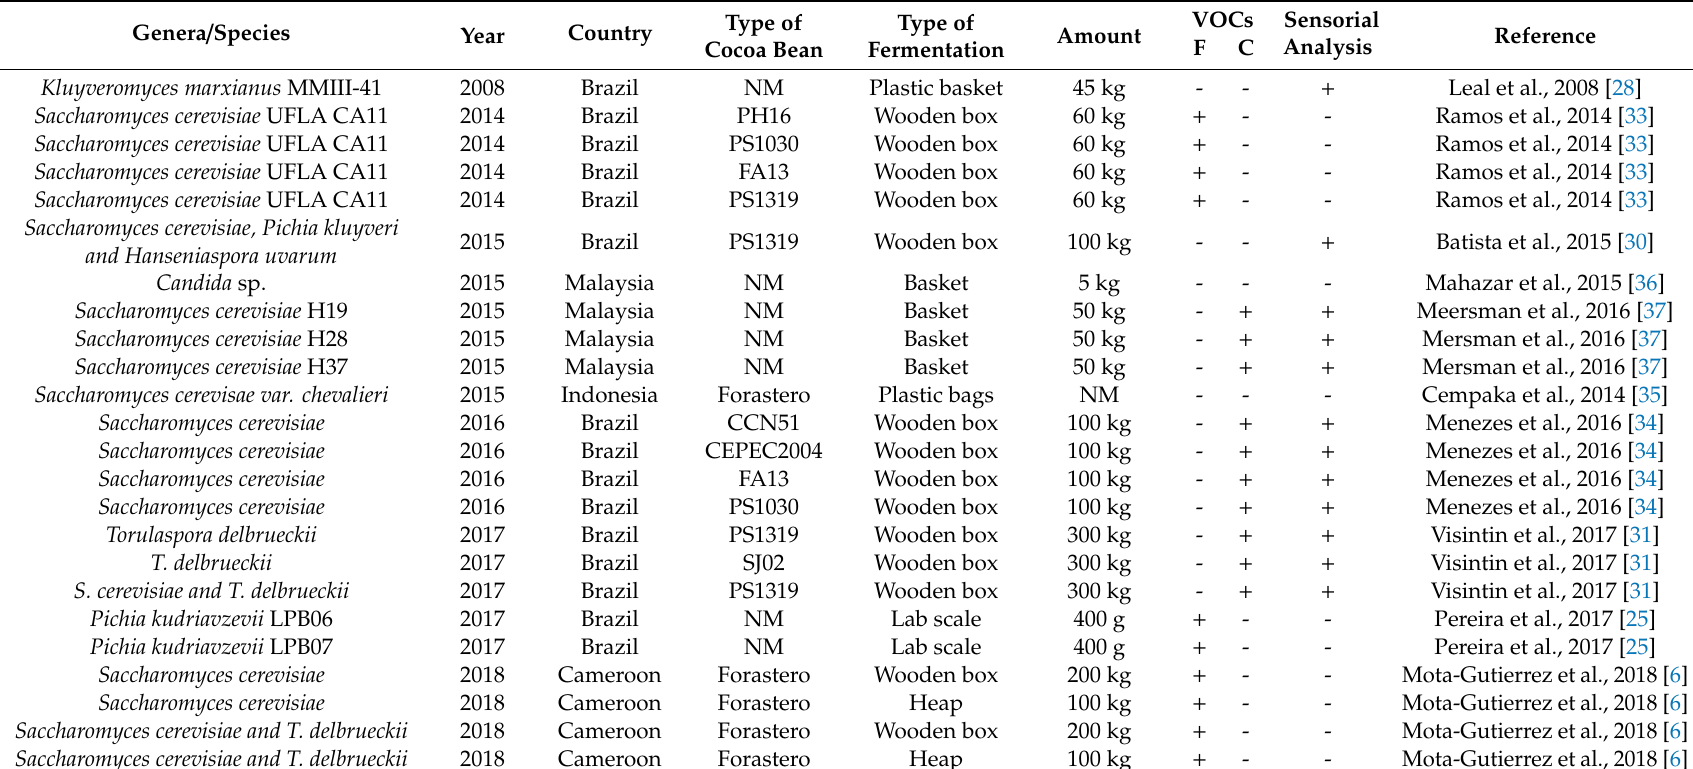
Table 1. Functional yeasts used as starters in cocoa